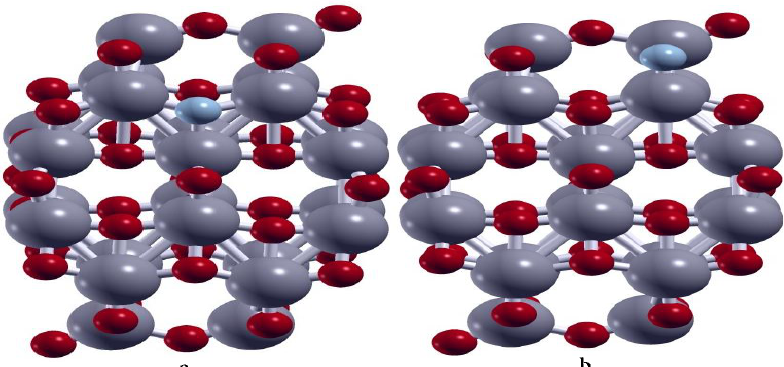
Fig. 2. Representation of the optimized N-doped TiO